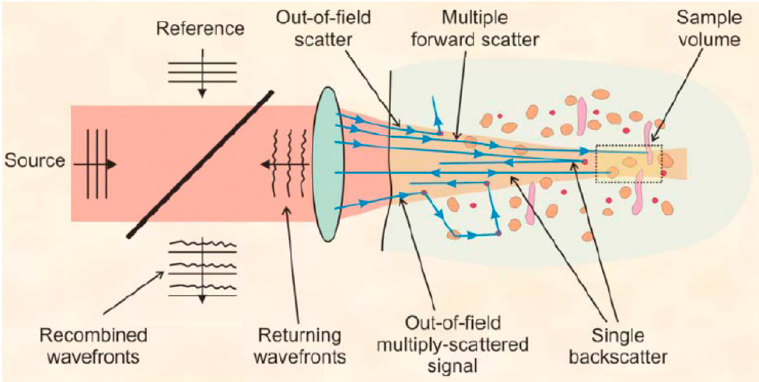
Figure 20. Single and multiple back scattered light [119].